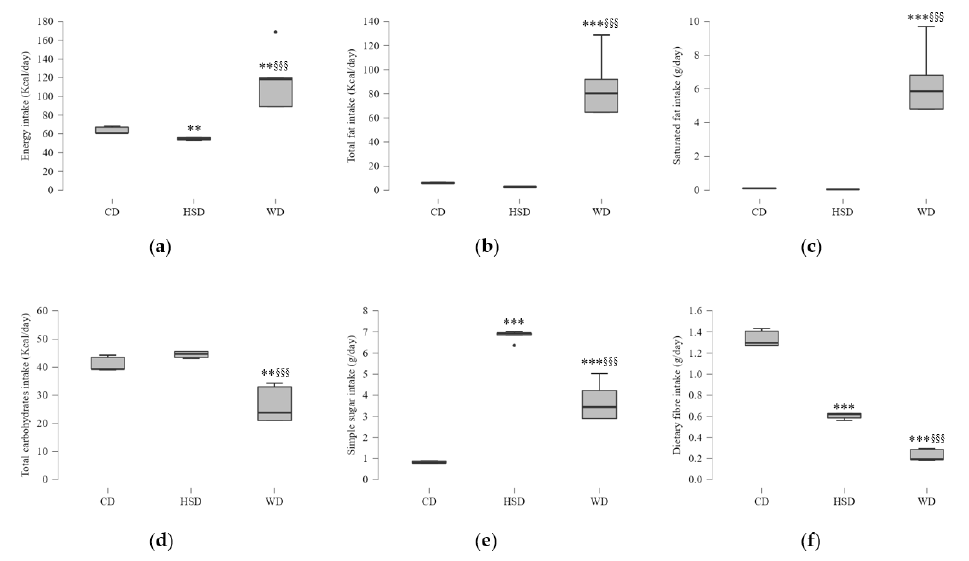
Figure 1. Graphic representation of the daily intake of energy and nutrients from chow-fed (CD), high-sugar diet (HSD), and Western diet (WD) groups. ( a ) Total energy intake from solid food and drink, although CD rats had access to water. ( b ) Energy from total fat intake. ( c ) Saturated fat intake (g/day). ( d ) Energy from total carbohydrate intake ( e ). Simple sugar intake (g/day). ( f ) Dietary fibre intake (g/day). Mean values ± standard deviation (SD) are plotted. Symbols * and § indicate significant differences (one-way ANOVA) compared to CD-fed group: ** p < 0.01, *** p < 0.001; HSD-fed group: §§§ p < 0.001 ( n = 9 rats per group).